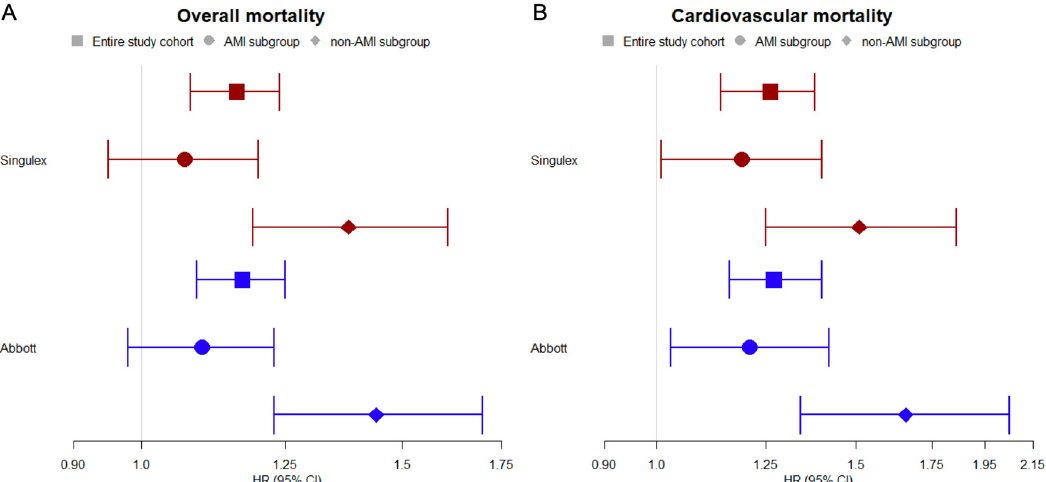
Figure 2. Cox regression analysis for overall mortality ( A ) and cardiovascular mortality ( B ) in the entire study cohort and in subgroups: AMI and non-AMI. Troponin levels were log-transformed. For adjustment variables of sex, age, and conventional cardiovascular risk factors body mass index, diabetes, smoking status, family history of coronary artery disease, hypertension, and hyperlipidemia were used. HR stands for hazard ratio. CI stands for confidence interval.